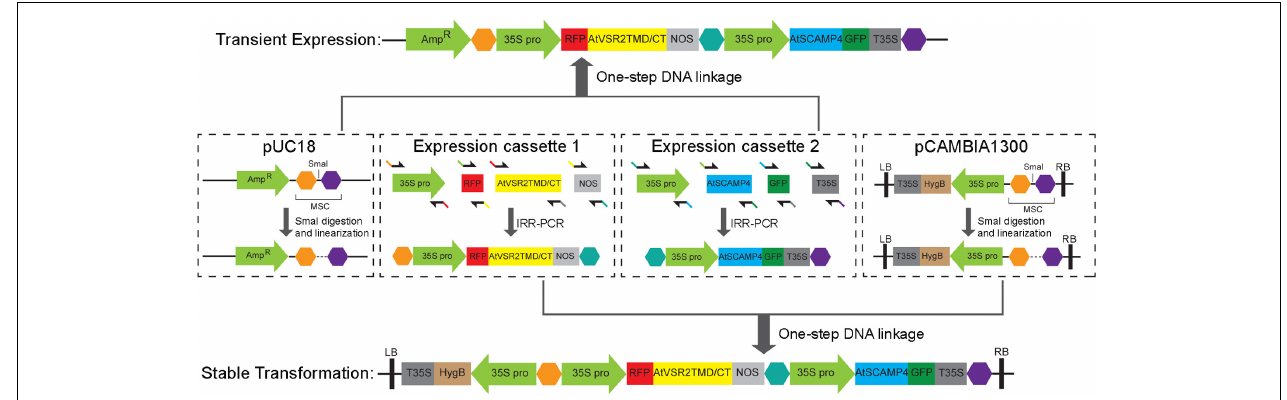
FIGURE 2 | The strategy of constructing a single vector for co-expressing multiple chimeric fluorescent fusion proteins. Schematics of the strategy for constructing a single expression vector for the co-expression of multiple chimeric fluorescent fusion proteins either for transient expression in plant cells or for stable transformation in plants. The expression vector is composed by multiple expression cassettes, each of which contains its own promoter (35S promoter), fluorescent tag (GFP or RFP), target protein (AtVSR2 or AtSCAMP4) and terminator (NOS) respectively, and is responsible for expressing its individual chimeric fluorescent fusion protein. Interlinkage of all the DNA molecules is conveniently achieved by an optimized isothermal in vitro recombination method mediated with the overlapping DNA